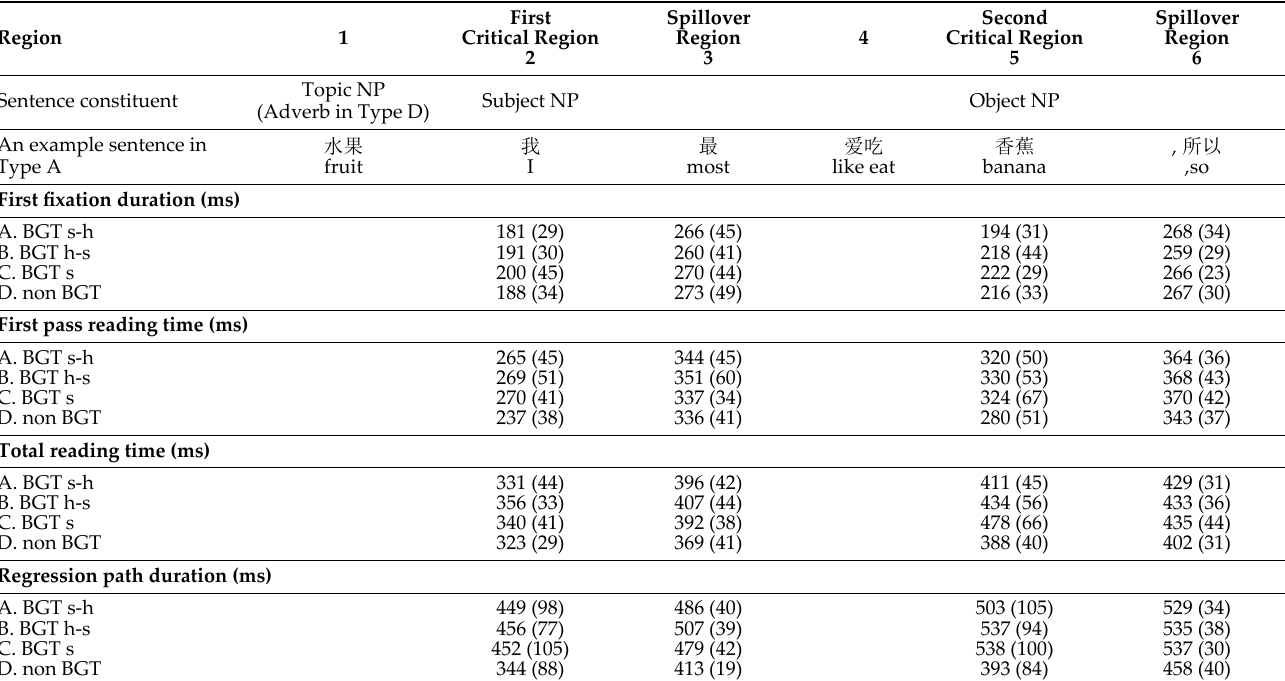
Table 4. Means (SD) of reading measures for intermediate L2